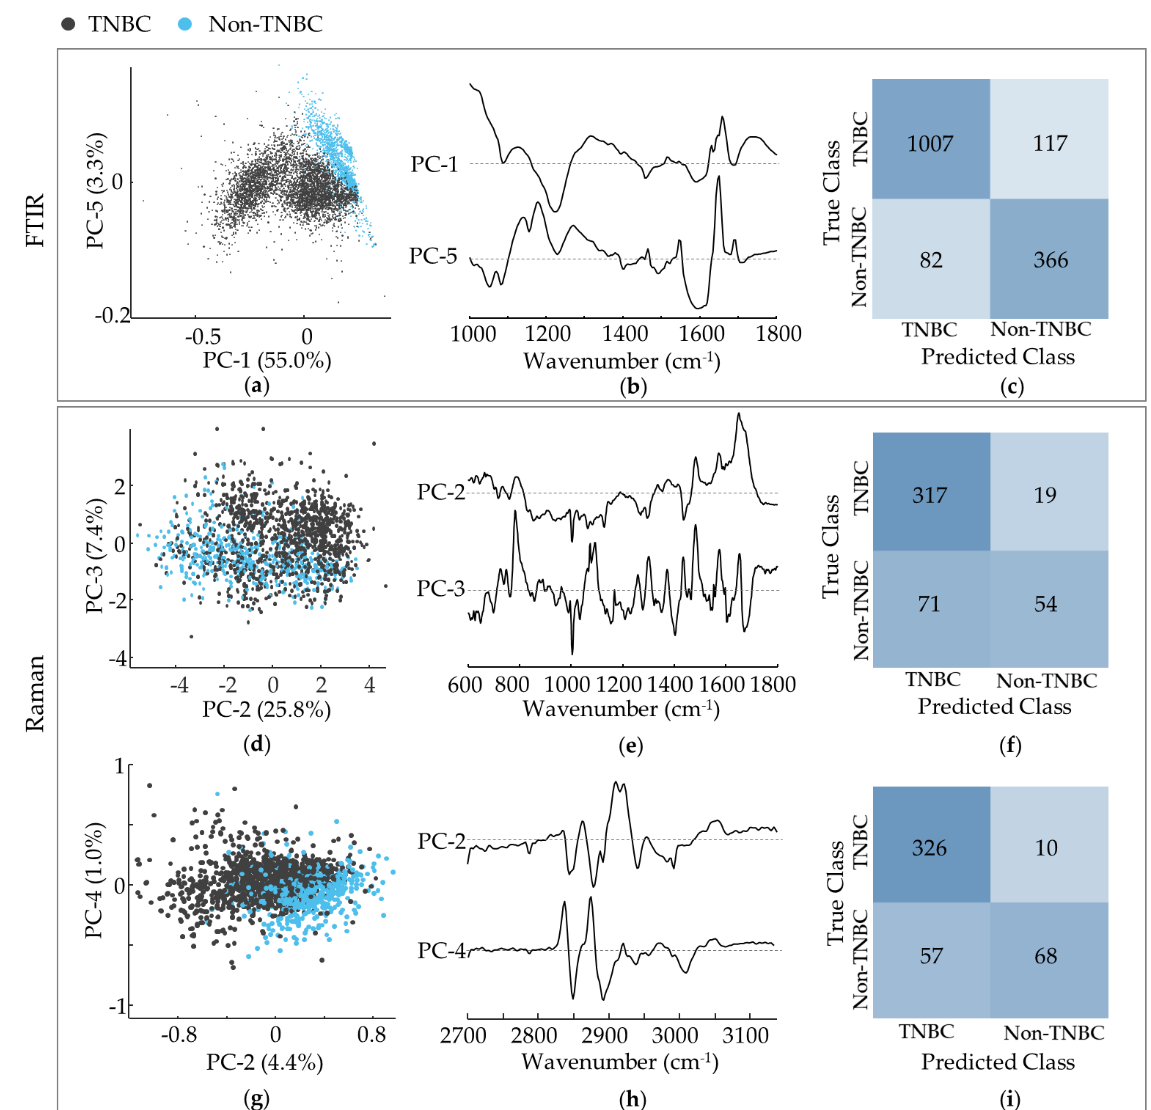
Figure 4. PCA of FTIR and Raman data for TNBC vs non-TNBC cells. ( a , b ) Score and loading plots of the FTIR fingerprint region. ( c ) Confusion table of the FTIR classification model tested on independent data. ( d , e ) Scores and loading plots of the Raman fingerprint region. ( g , h ) Scores and loading plots of the Raman high wavenumber region. ( f , i )—Confusion tables of the Raman fingerprint ( f ) and high wavenumber ( i ) classification models tested on independent data.